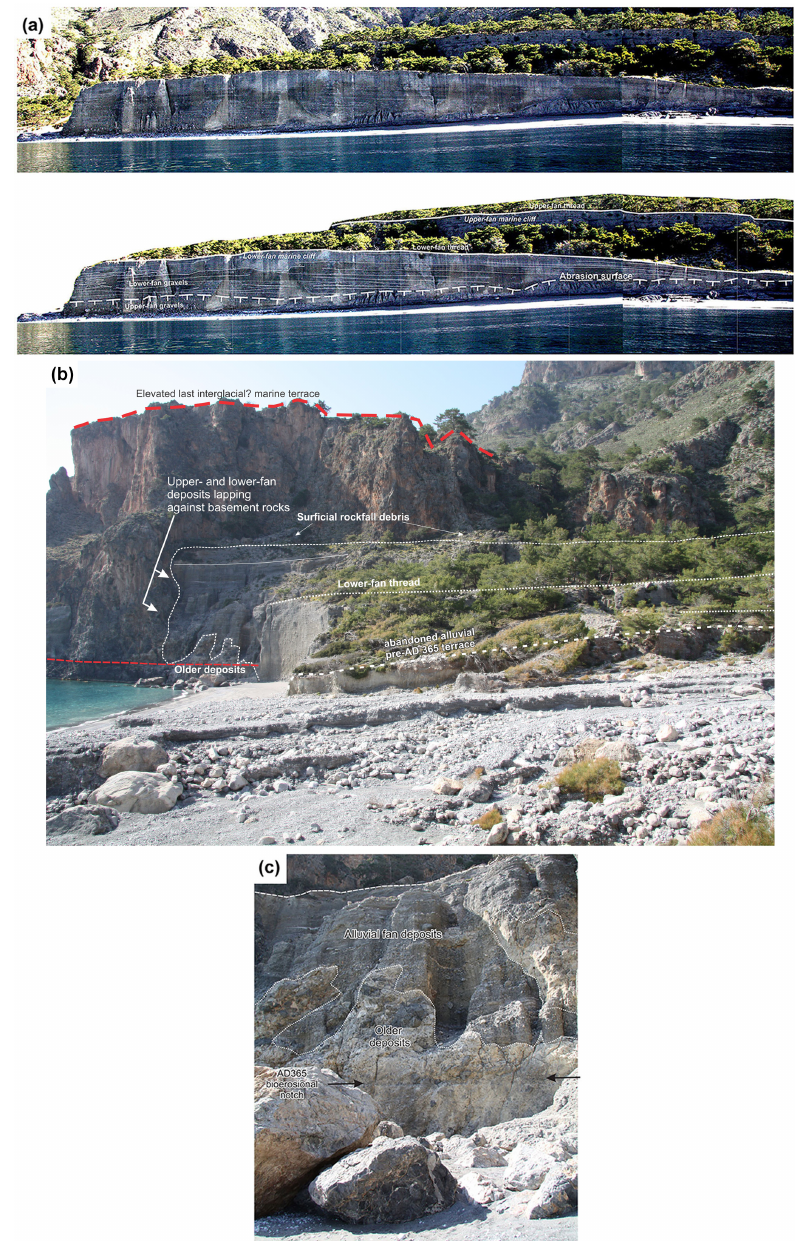
Figure 6. (a) The present marine cliff at Domata (above), annotated to highlight various sedimentary relationships (below). The cliff com- prises mostly moderately bedded gravels of the lower-fan sequence. The lower contact of the lower-fan gravels (white dashed line) is irregular and sub-horizontal, with lower-fan bedding (white dotted lines) lapping onto it. Some individual horizons within the lower-fan deposits can be traced laterally for hundreds of metres, but channelling, bed-lensing and pinch-outs are present. Note also the exposed marine cliff beneath the upper-fan surface (behind the forested lower-fan surface). (b) Looking west across the Klados River mouth (foreground), the uplifted shoreline attributed to the AD365 earthquake (dashed red line, lower left) aligns well with a low terrace riser on the west side of the river (thick dashed white line, middle). Incision of the modern channel below the surface is attributable to post-earthquake adjustment to new base levels. Note the sea cliffing of the last interglacial marine terrace (thick dashed red line at the top of the image) and the upper- and lower-fan deposits. The upper fan and western parts of the lower fan are overlain by accumulated rockfall debris and the solid thin white line approximates its surface. The lower-fan surface is marked with a fine dotted white line. (c) Annotated image of the west end of Domata beach illustrating the relationship between the unconformity at the base of the fan sequence and the AD365 bioerosional notch. Specifically, the picture shows a dissected erosional surface on older sediments that predates the fan deposits and the AD365 bioerosional notch post-dating both the erosional surface and the fan deposits that rest on it. The picture was taken about 150m west of the mouth of the Klados